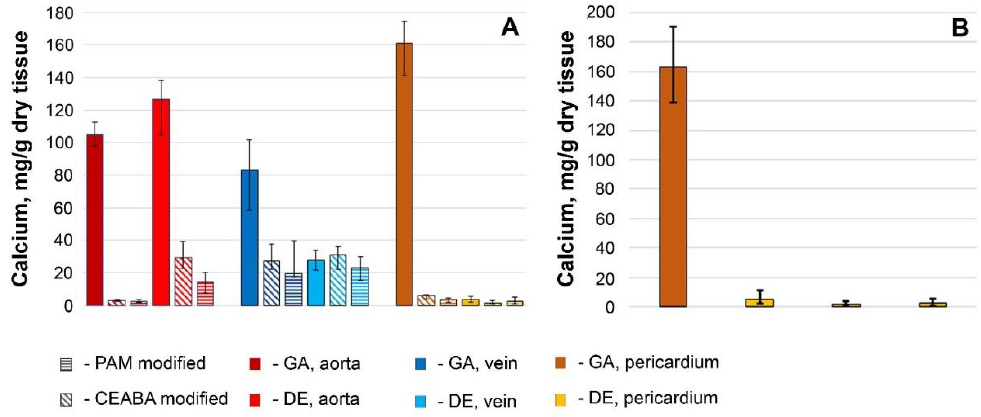
Figure 8. ( A ) Calcium content in all studied biomaterials on day 60 after implantation. ( B ) Calcium content in bovine pericardium on day 120 after implantation.